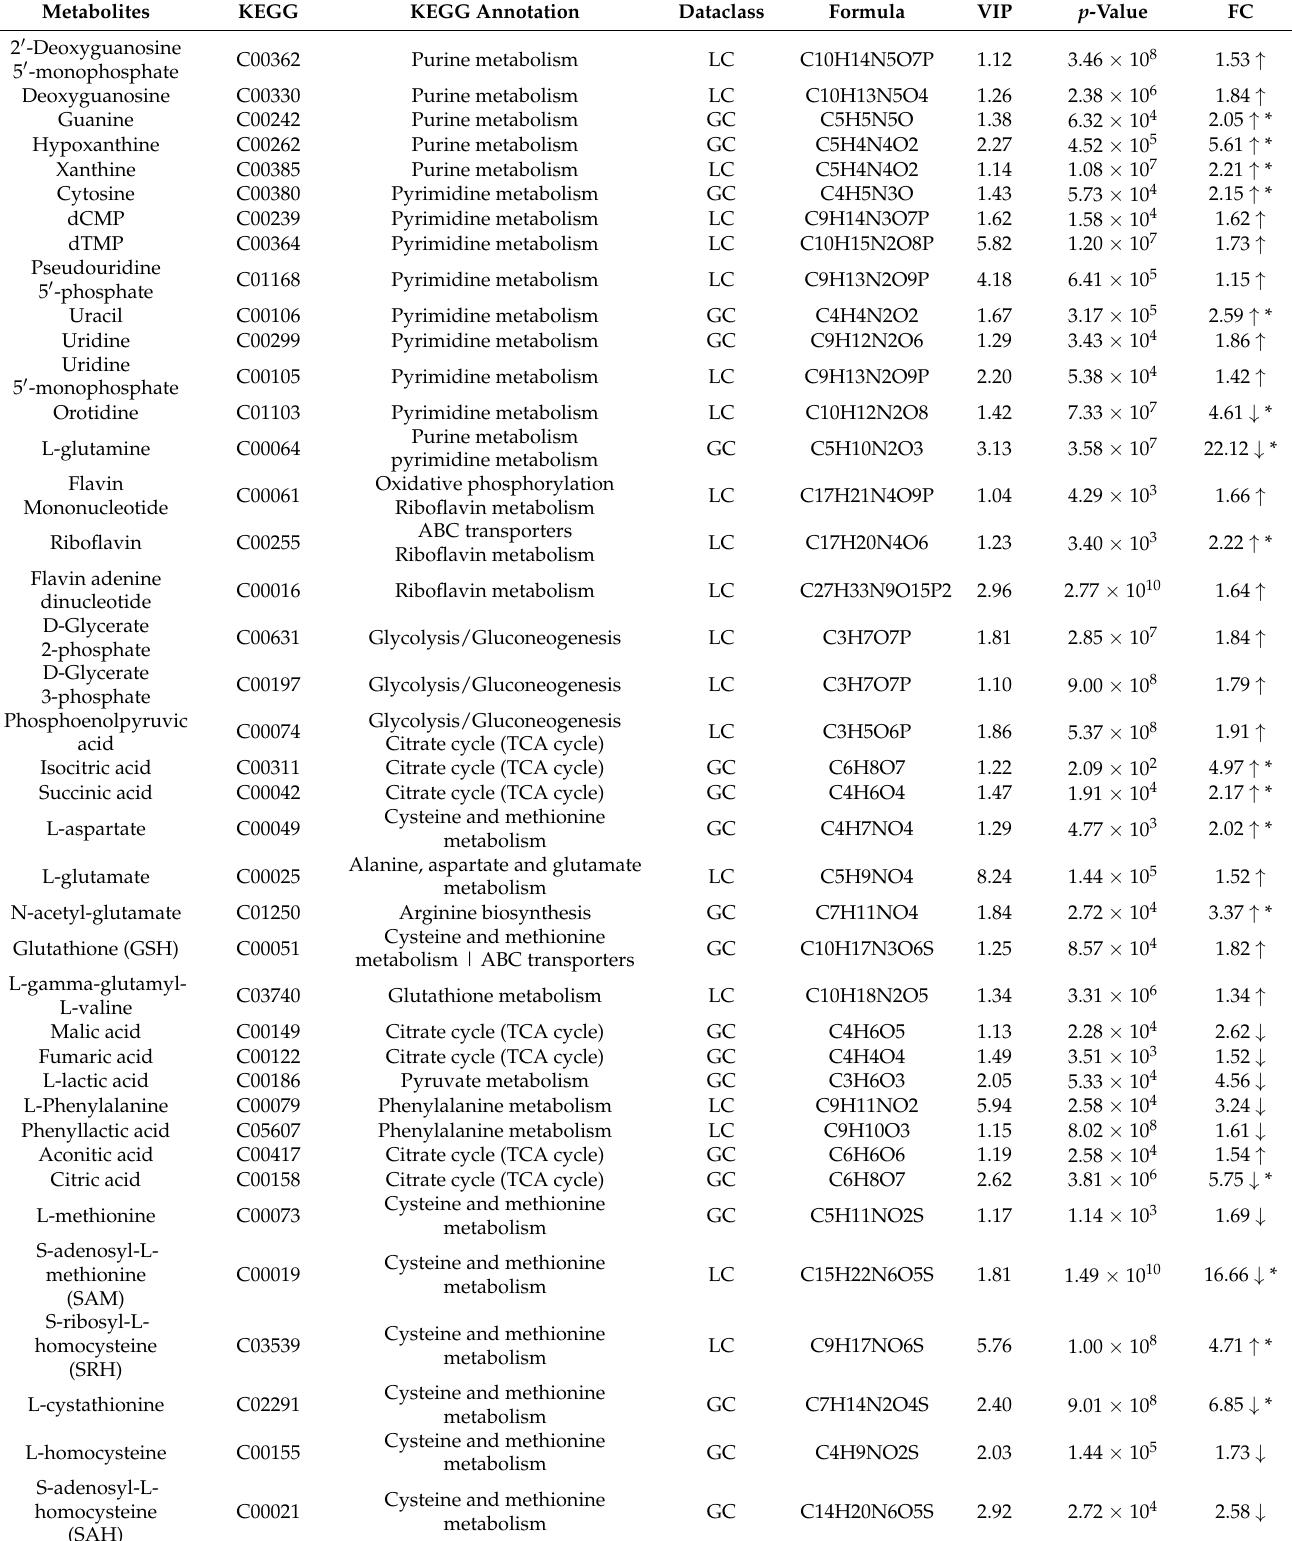
Table 3. Differential metabolites involving PTS, nucleotide synthesis, pyruvate metabolism, cysteine and methionine